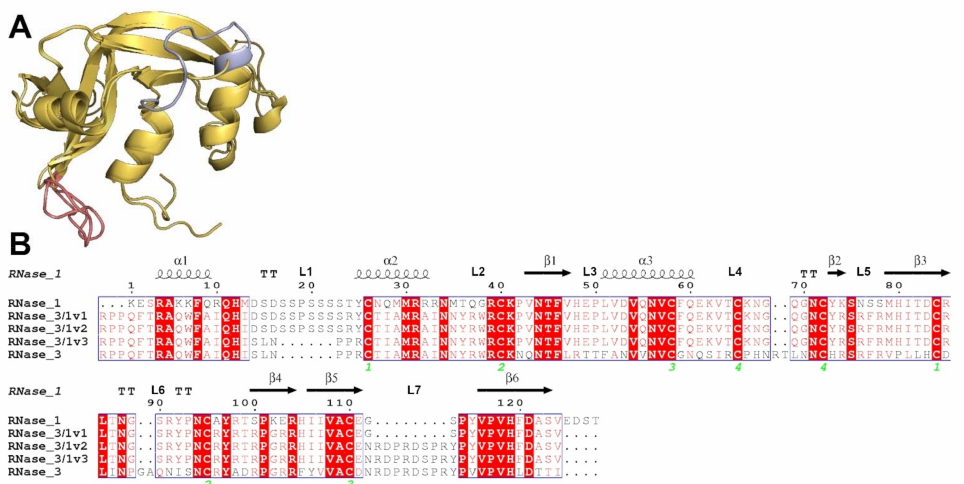
Figure 1. ( A ) Overlapping of the models of RNase 3/1-v1-3 obtained by Modeller 9.12 [30]. In red, the antimicrobial loop of RNase 3, added in RNase 3/1-v2. In blue, the flexible loop of RNase 1, removed in RNase 3/1-v3. In beige, the RNase 1 skeleton. ( B ) Alignment between RNases 1, 3 and the three versions of RNase 3/1. The fully conserved amino acids are highlighted in red. The residues that are not conserved but have similar properties are marked with red letters. The secondary structure is indicated above the alignment. The green numbers indicate the disulphide bridges. The alignment was conducted using Clustal Omega [31], and the image was obtained with ESPript7 (http://espript.ibcp.fr/ESPript/)